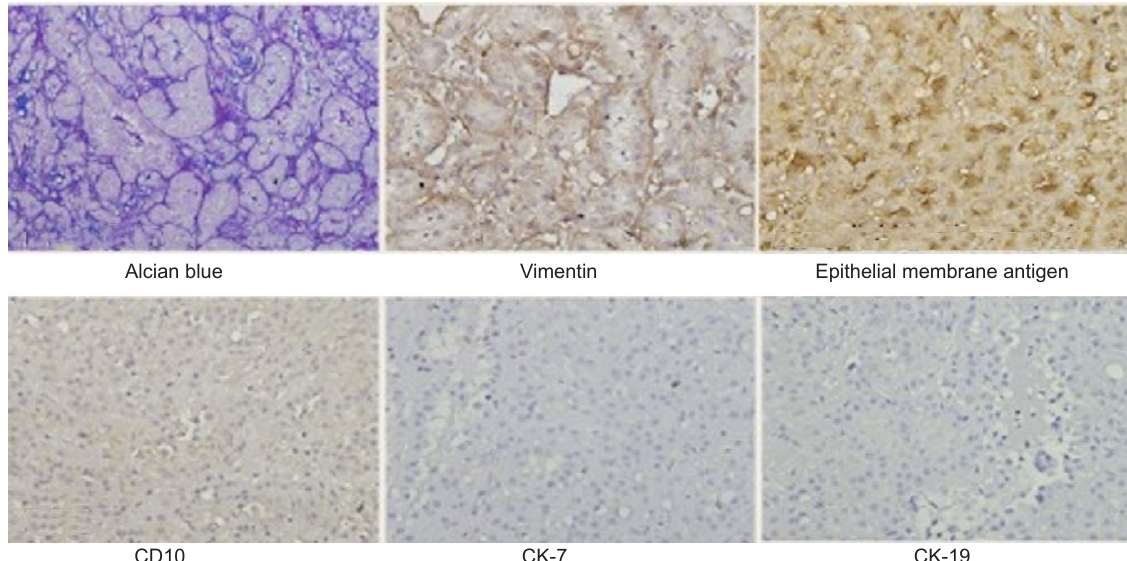
Figure 3: On immnunohistochemistry, the tumor characteristically shows the mucoid material is highlighted in blue on Alcian blue, and the tumor cells are immunopositive for vimentin, epithelial membrane antigen, and are negative for CD10, CK-7, and CK-19.